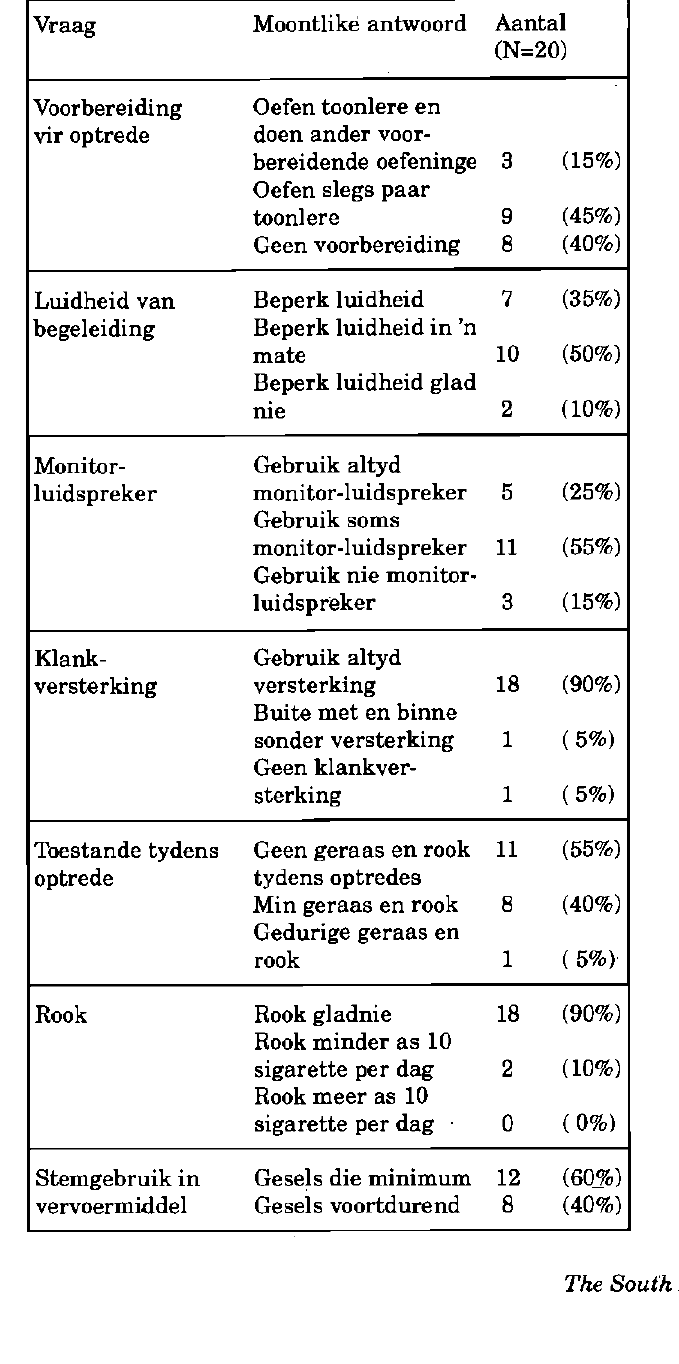
terugvoer te kry. Daar is selfs 2 sangers wat nie altyd TABEL 9: Die blootstelling aan risikofaktore by